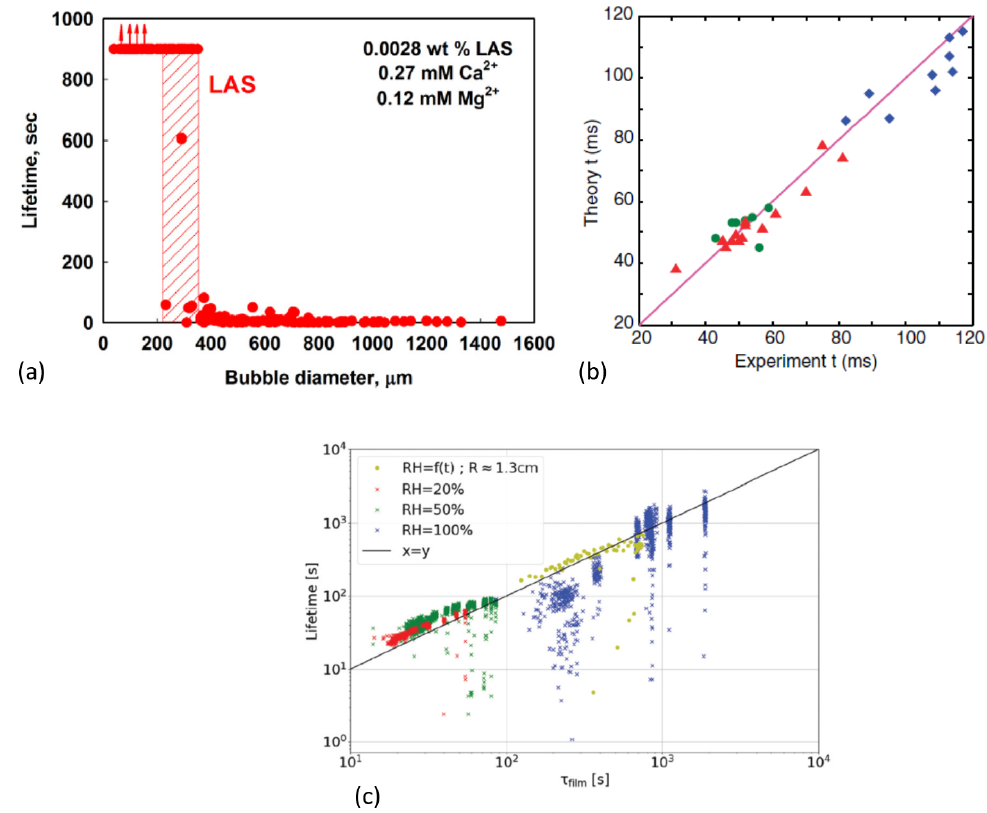
Figure 8. ( a ) Lifetime of microbubbles as a function of their diameter. An outstanding stability is observed for bubbles whose diameter is smaller than 200 µ m. The figure is extracted with authorization from reference [66]. ( b ) Comparison between measured coalescence time between two bubbles and the Stokes-Reynolds-Young-Laplace model proposed by the authors of reference [36], where the figure comes from with authorization. ( c ) Comparison between the measured lifetime of centimetric bubbles obtained for different atmospheric humidities and bubble size and the predicted lifetime obtained taking into account the film drainage and evaporation. Figure extracted from reference